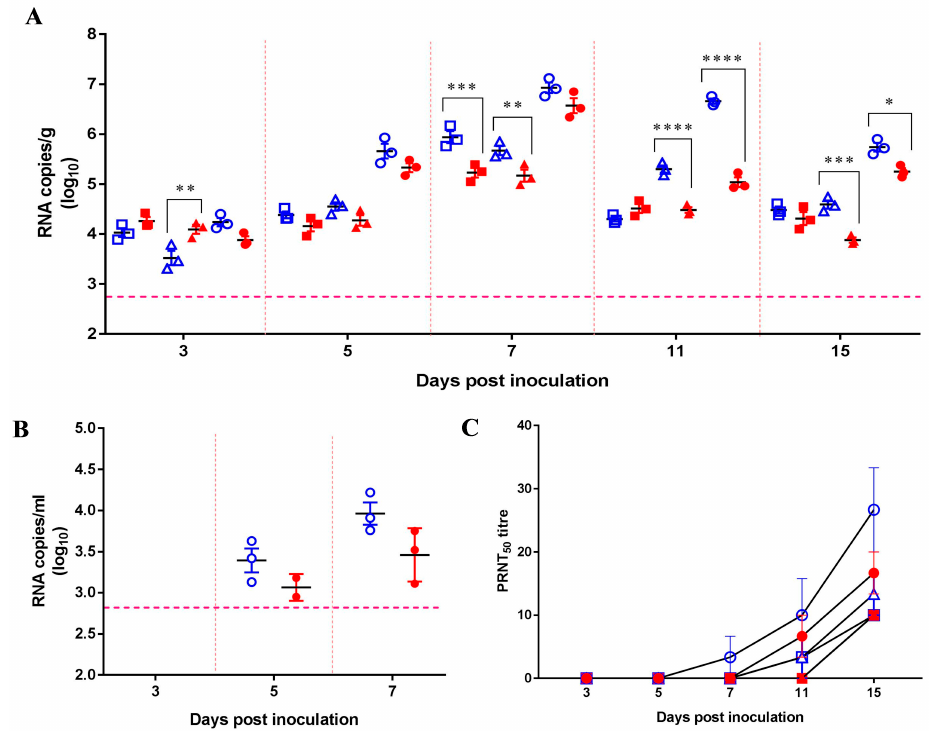
Figure 2. Virus replication, shedding, and seroconversion in mice intranasally inoculated with JEV. Four-week-old mice were i.n. inoculated with different doses (10 2 , 10 4 , or 10 6 pfu/50 µ L) of the SCYA201201 or SA14-14-2 virus. The SCYA201201 virus is marked with hollow symbols (10 2.0 with (cid:3) , 10 4.0 with (cid:52) , and 10 6.0 with ), while the SA14-14-2 virus is marked with solid symbols (10 2.0 with (cid:4) , 10 4 with (cid:78) , and 10 6 with • ). ( A ) The viral RNA load in lungs at 3, 5, 7, 11, and 15 dpi is measured using real-time RT-PCR and expressed as RNA copies per gram (Mean ± SEM). ( B ) The viral RNA load in oronasal swabs collected at 3, 5, and 7 dpi was measured using real-time RT-PCR assay and expressed as RNA copies per mL (Mean ± SEM). ( C ) The sera were collected from infected or uninfected mice at 3, 5, 7, 11, and 15 dpi, and neutralizing antibodies were detected by PRNT. The horizontal dotted lines indicate the limit of detection (* P < 0.05, ** P < 0.01, *** P < 0.001, and **** P <